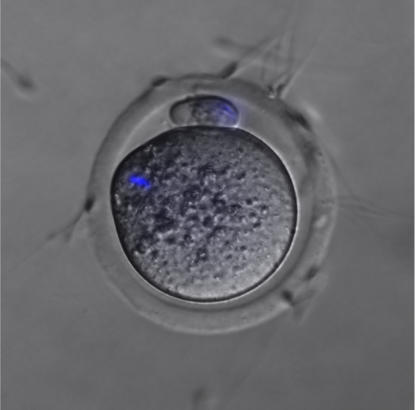
The first polar body (the smaller cell atop the oocyte) deforms the mammalian egg away from its encapsulating zona pellucida, creating a gap.